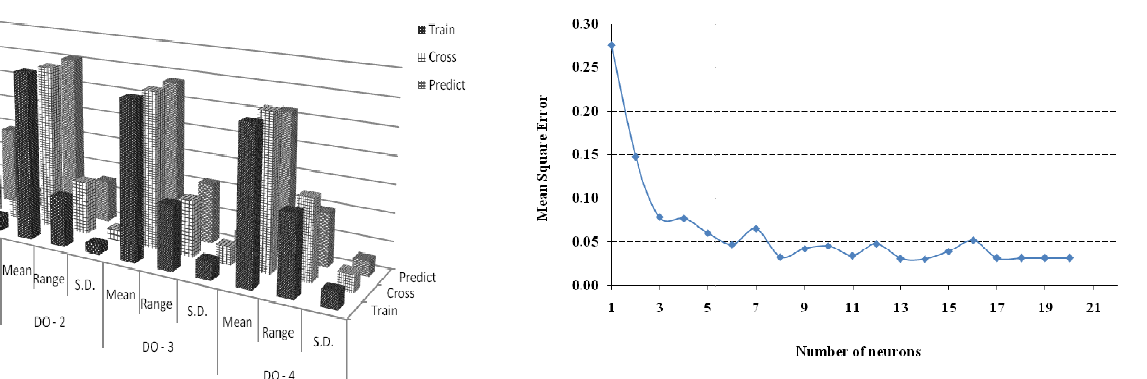
Fig. 6: Relationship between Relationship between the number of neurons and MSE number of neurons and MSE Fig. 6. Relationship between the number of neurons and MSE.